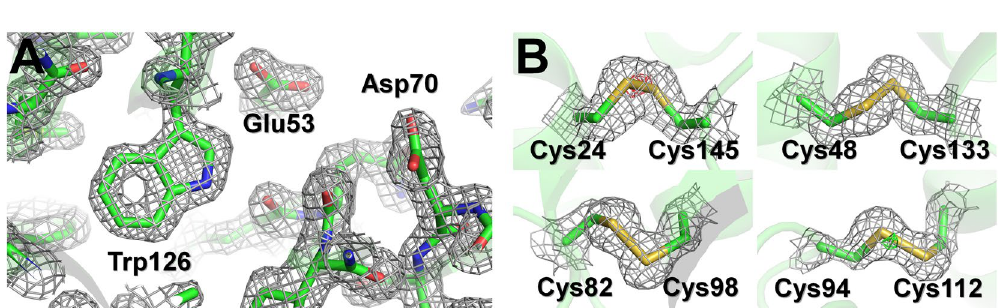
Figure 3. Electron density map of room-temperature lysozyme embedded in beef tallow. ( A ) 2mFo-DFc electron density map (grey mesh, 1.2σ) of lysozyme ( B ) 2mFo-DFc (grey mesh, 1.2σ) and mFo-DFc (green, 3σ; red, − 3σ) electron density map around disulfide bonds of